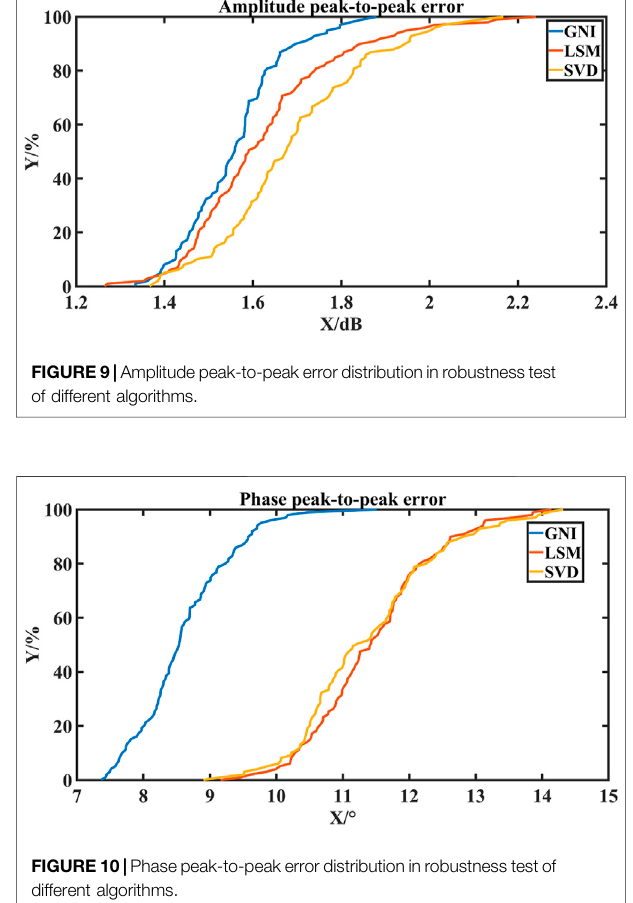
shown in Table 2 . It can be seen from Table 2 that the amplitude error of the quiet zone obtained by the GNI algorithm is 1.04 dB and the phase error is 3.94 ° . In order to facilitate the observation of fl uctuations, we selected a cross section indicated by the black dashed curve in Figure 5 . And the cross-sectional amplitude error and phase error is shown in Figure 6 .